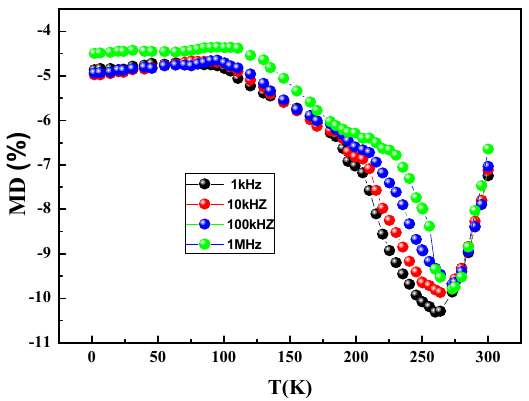
Figure 11. Effects of MD (magnetodielectric) properties at different frequencies.